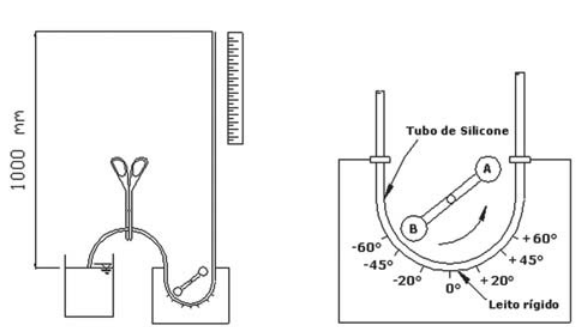
Fig. 1 – Desenho esquemático do sistema de medidas de velocidade de queda e ângulos padronizados